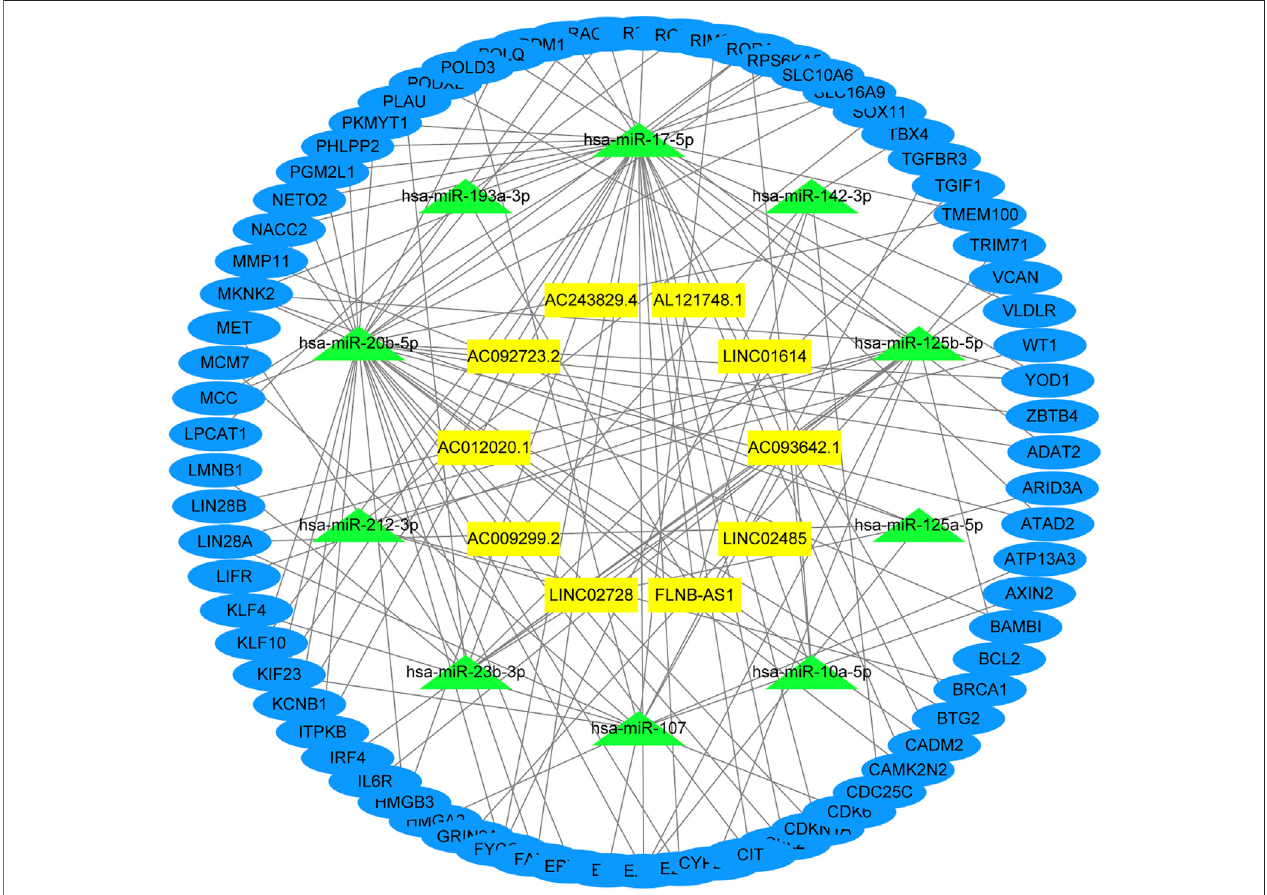
FIGURE 6 | Function analysis of these 10 lncRNAs. The lncRNA-miRNA-mRNA network was constructed by integrating differential genes and predicted results from miRCode, TargetScan, miRDB, and miRTarBase database.